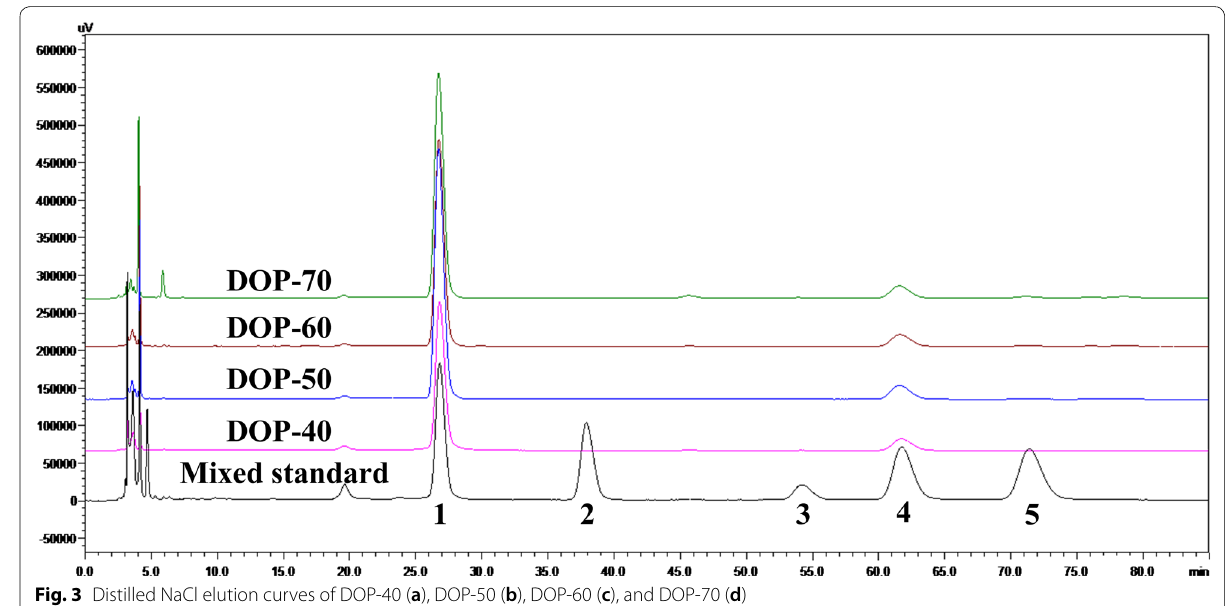
Fig. 3 Distilled NaCl elution curves of DOP-40 ( a ), DOP-50 ( b ), DOP-60 ( c ), and DOP-70 ( d )